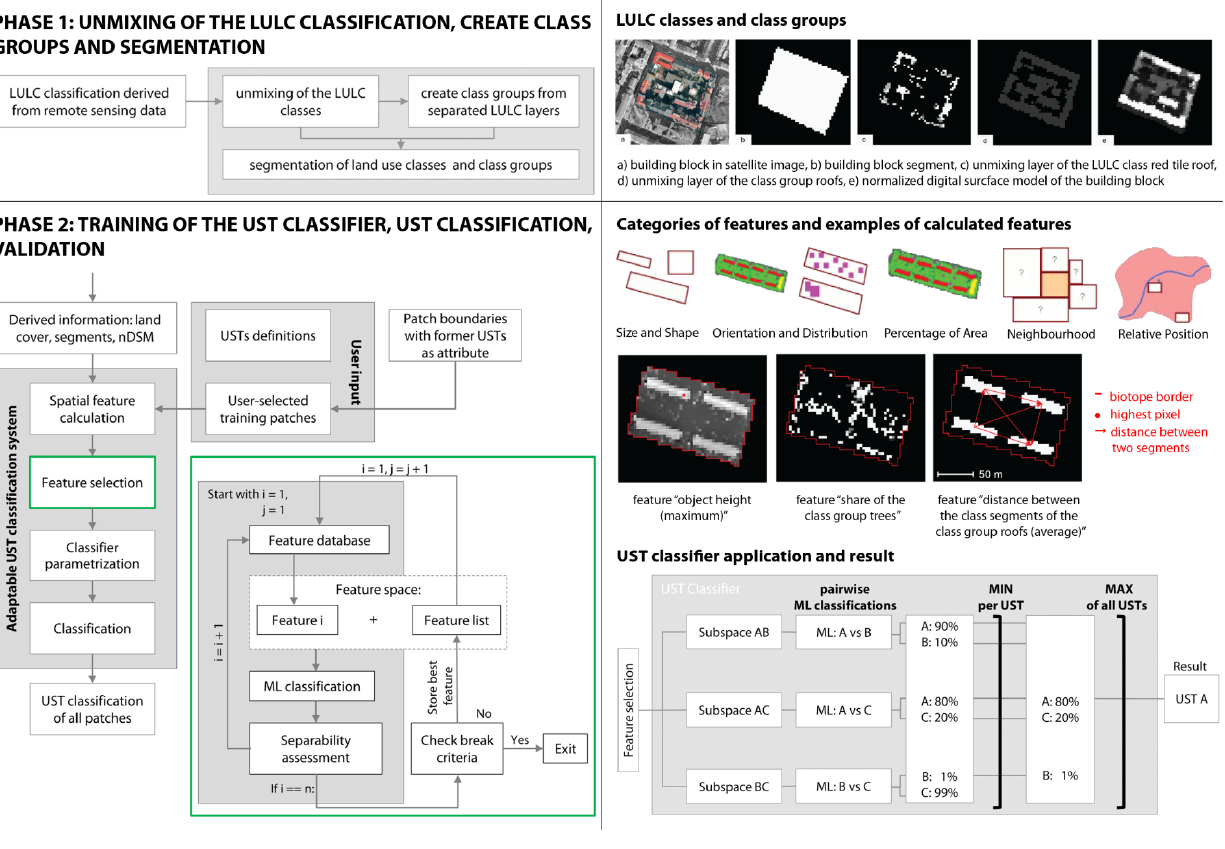
Figure 3. Flow chart of the urban structure type classification, modified after